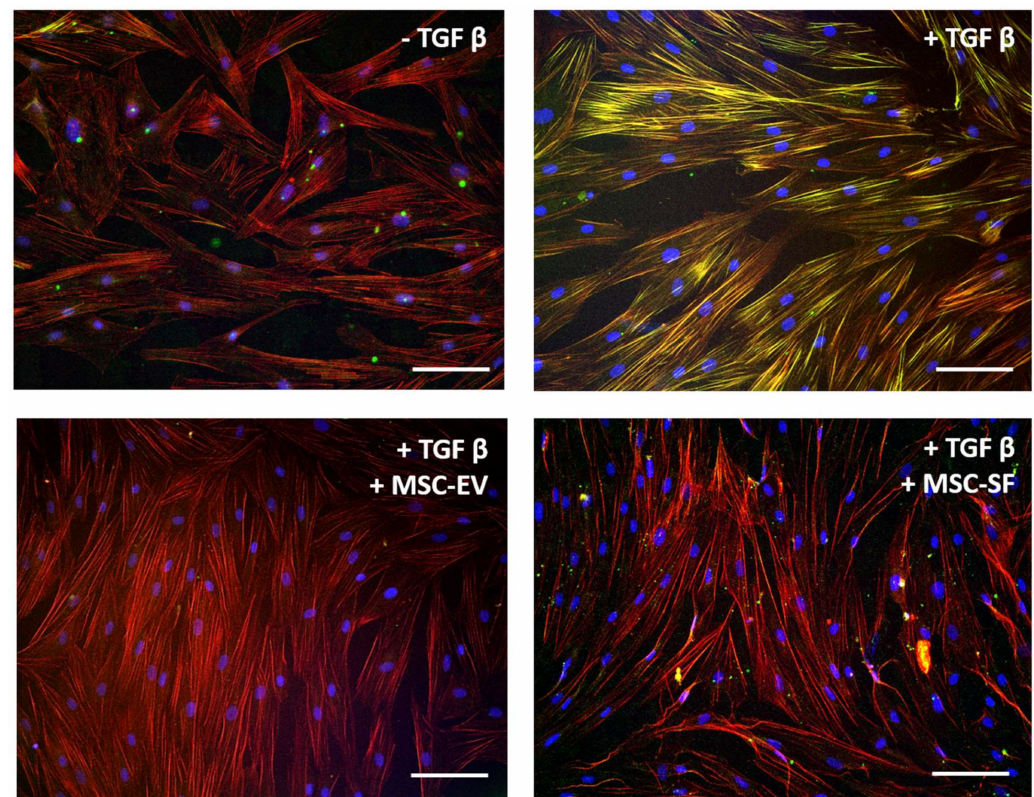
Figure 2. MSC-CM fractions added simultaneously with TGFbeta prevented the TGFbeta-induced aSMA redistribution into stress fibers in fibroblasts. Immunofluorescent analysis (aSMA (green), phalloidin (red), DAPI (blue)) of the content of aSMA in serum-free cultured control fibroblasts ( − TGFbeta), in fibroblasts after exposure to TGFbeta ( + TGFbeta) and TGFbeta with the components of MSC-CM ( + TGFbeta + MSC-EV; + TGFbeta + MSC-SF). Scale bar: 100 µ